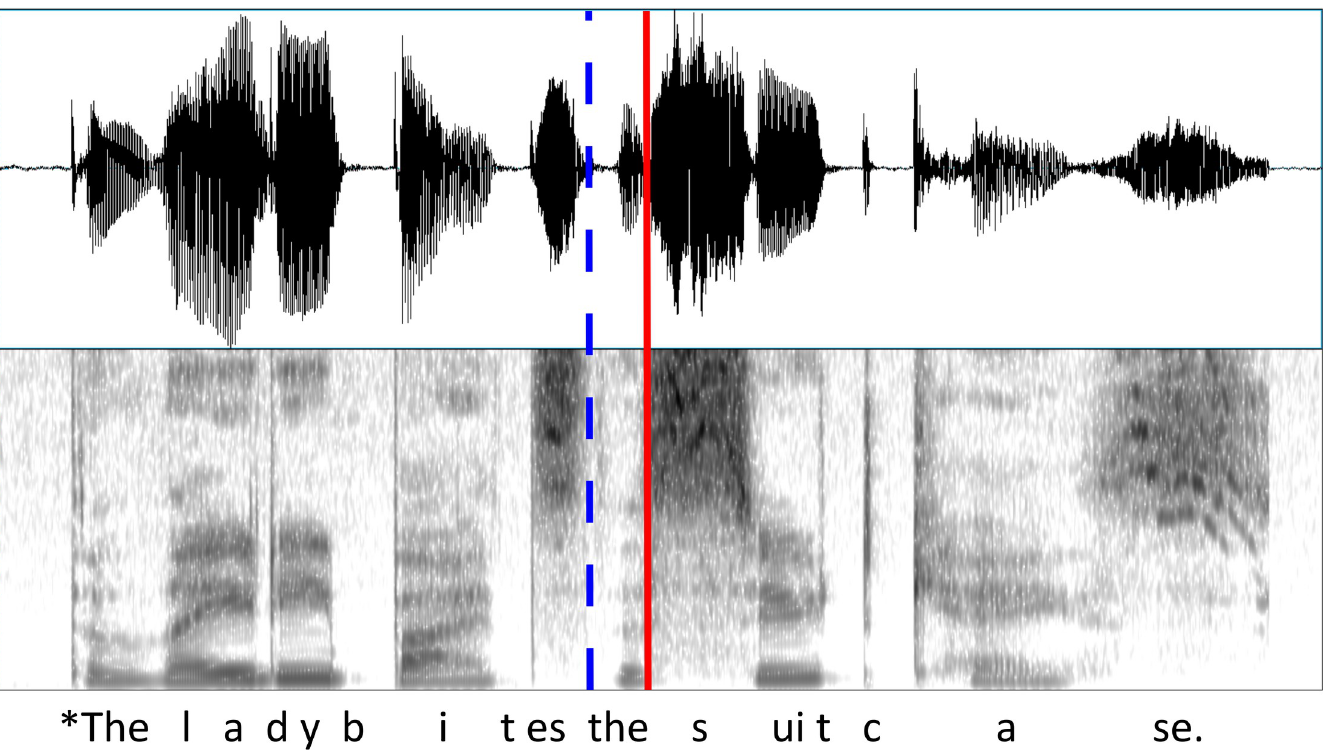
Fig 2. Waveform and spectrogram of sample stimulus sentence “The lady bites the suitcase”. The splicing point is shown as a dotted blue line and the time-locking point of the ERP is shown as a solid red line.